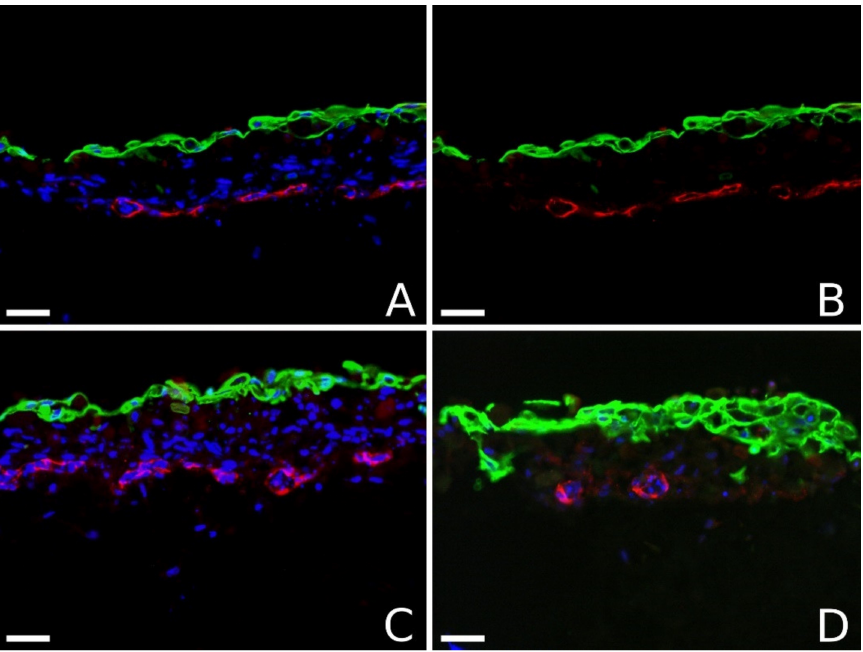
Figure 4. Vessel formation in bioprinted skin tissue. Sections through printed skin constructs consisting of human dermal fibroblasts with an integrated grid of human endothelial cells and human epidermal keratinocytes. Rat tail collagen type I was used as the bioink. Sections were prepared three days after printing, and staining was performed using cytokeratin 14 (green; stains keratinocytes), CD31 (red; stains endothelial cells), and Hoechst 33,342 (blue; stains all nuclei). Panels ( A , B ) show the same section depicted on the right without Hoechst 33,342 nuclear staining; they clearly show that the endothelial cells have formed a tubular structure, through which the section passes several times. Panel ( C ) shows a section that is partially vertical and partially oblique through capillaries. In panel ( D ), two vessels are sectioned vertically. Scale bars are 100 µ